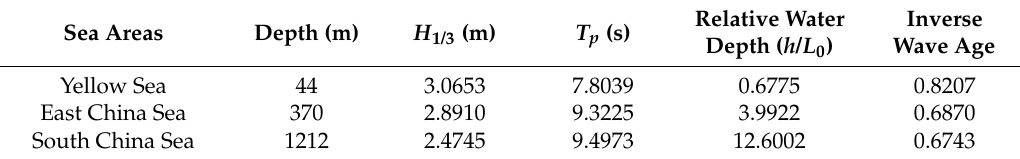
Table 5. The relative water depth and wave parameters for wind speed of 10